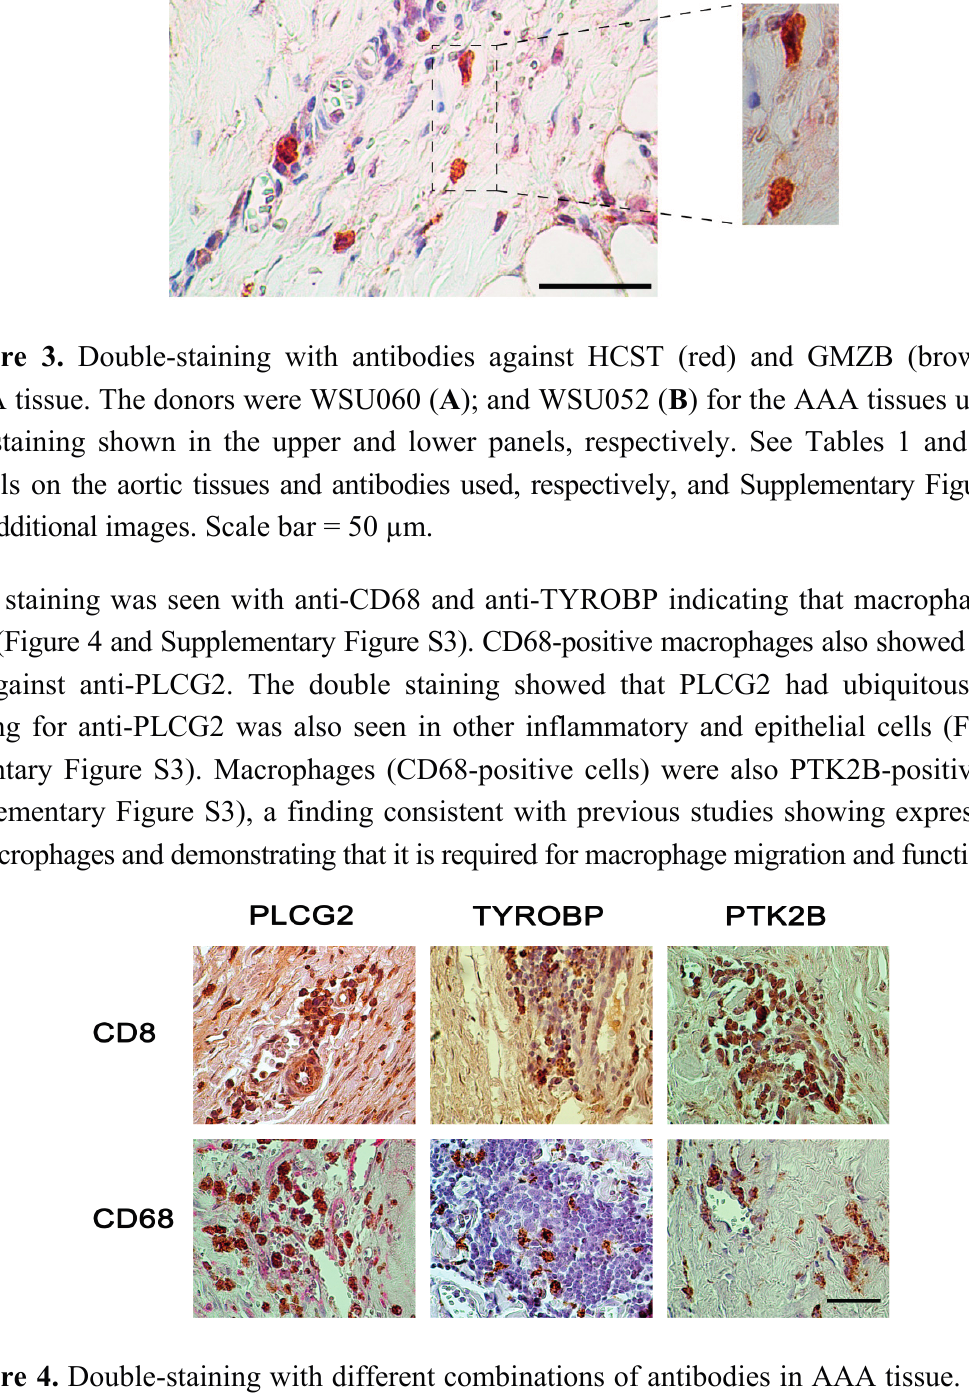
Figure 4. Double-staining with different combinations of antibodies in AAA tissue. CD68 staining identifies monocytes and macrophages, and CD8 identifies cytotoxic T-cells. For the CD8–PLCG2 double-staining (upper left image), brown color is for PLCG2 and red for CD8. For all other images, brown color is for CD8 or CD68 and red color is for PLCG2, TYROBP, or PTK2B. See Tables 1 and 2 for details on the aortic tissues and antibodies used, respectively, and Supplementary Figures S2 and S3 for additional images. The slides were counterstained with hematoxylin, and nuclei stain blue-purple color. Lymphocytes show intense blue staining, since they have little cytoplasm. Scale bar = 50